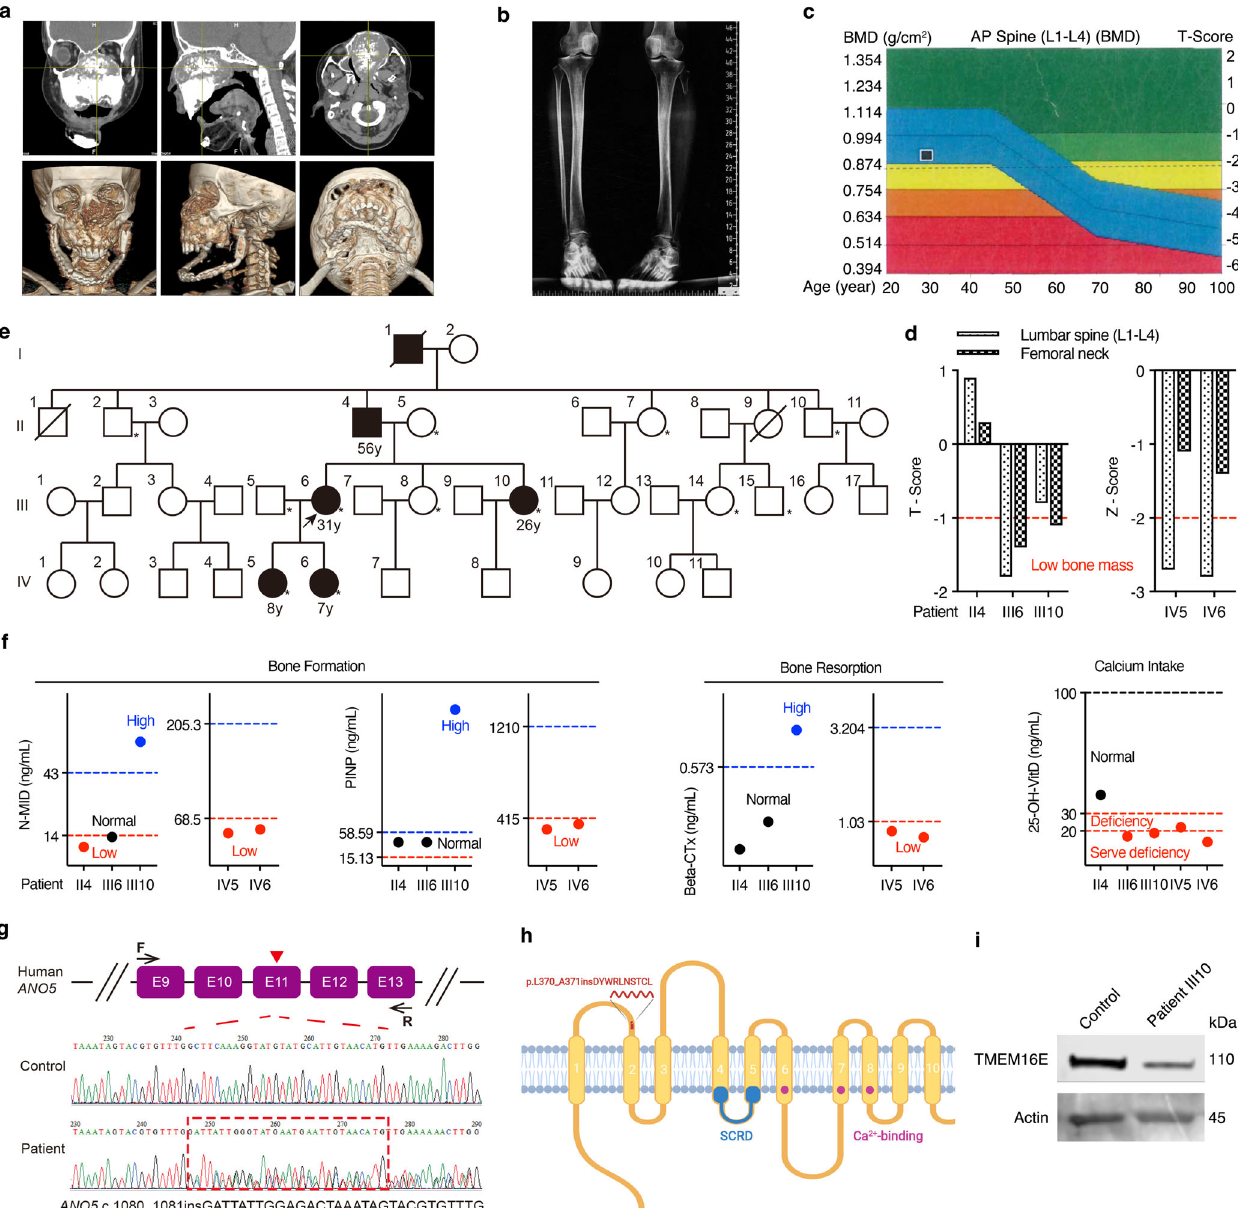
Fig. 1 Patients with GDD and osteopenia carrying ANO5 insertion mutations present loss of TMEM16E. a 3D reconstruction image of the maxillofacial CT of the proband (III6). b Radiographs of the lower limbs of the proband (III6). c DXA showed low BMD at lumbar spine L1 – L4 of the proband (III6). The clinical examination images were original from Shanghai Ninth Hospital Rare Diseases Database. d Low T -scores and Z scores were assessed by DXA in all affected patients. e Pedigree demonstrating the AD inheritance pattern of GDD. Generation, I – IV; males, squares; females, circles; patients, shaded black squares or circles; the proband (III6), an arrow; extracted DNA samples, an asterisk; age is labeled below. f Bone formation markers, bone resorption markers, and calcium intake markers of all patients were determined. g Schematic representation of the frameshift insertion on ANO5 exon 11 (top) and Sanger sequencing validation of the frameshift in patient RNA-coding sequences compared with control sequences (bottom). Created based on human cDNAs sequence for ANO5 (NCBI; GenBank accession no. NM_213599.3). h Schematic representation of the TMEM16E protein, which includes 10 TMDs, an SCRD, and three calcium-binding sites. The insertion site is indicated as a red line in the fi rst extracellular loop. Created based on the human ANO5 (TMEM16E) sequence (Swiss Prot ID: Q75V66) with BioRender.com. i Representative images showing TMEM16E expression in PBMCs by Western blotting of samples from controls and